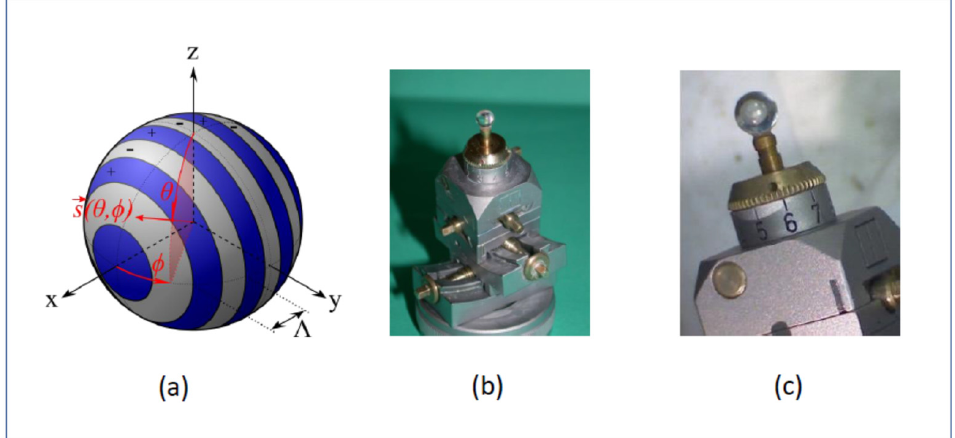
Figure 6. ( a ) Scheme of a periodically poled crystal oriented in the dielectric frame (x, y, z) where (𝜃, 𝜙) are the spherical angle coordinates of the direction 𝑠⃗ ; ( b ) 5%MgO:PPLN sphere with a grating period Λ = 32 µm and a diameter of 3.9 mm; ( c ) PPRKTP sphere with a grating period Λ = 38.52 µm and a diameter of 4.76 mm.